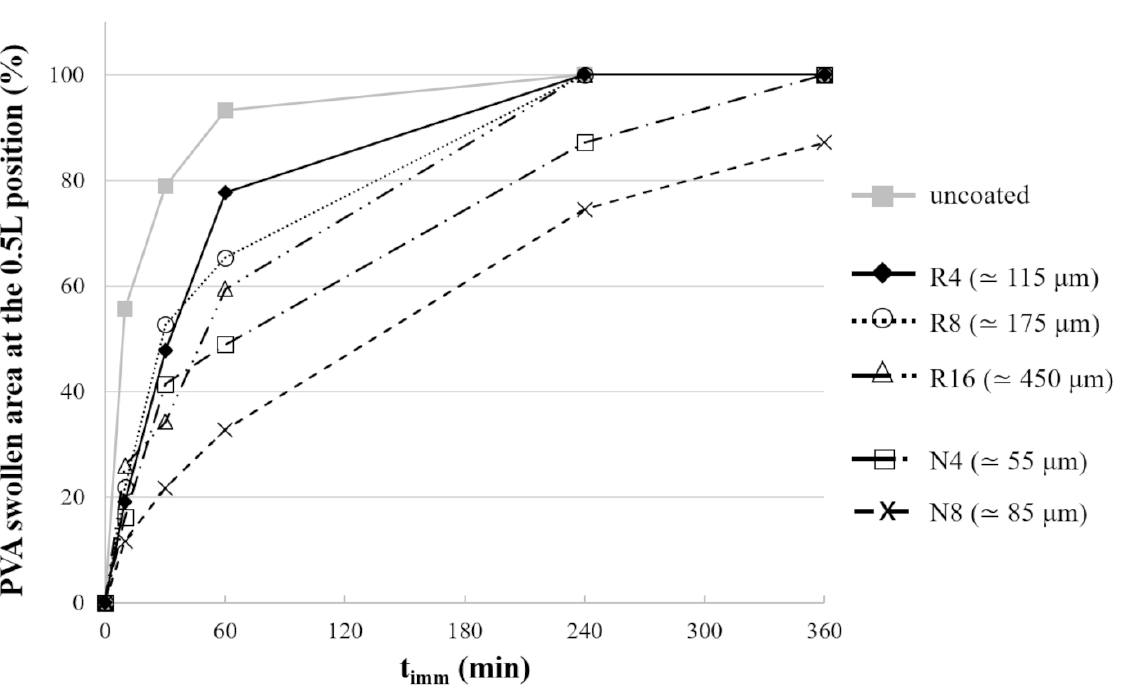
Figure 9. Profiles of swollen area in the central cross-section of uncoated and coated samples as a function of the immersion time.